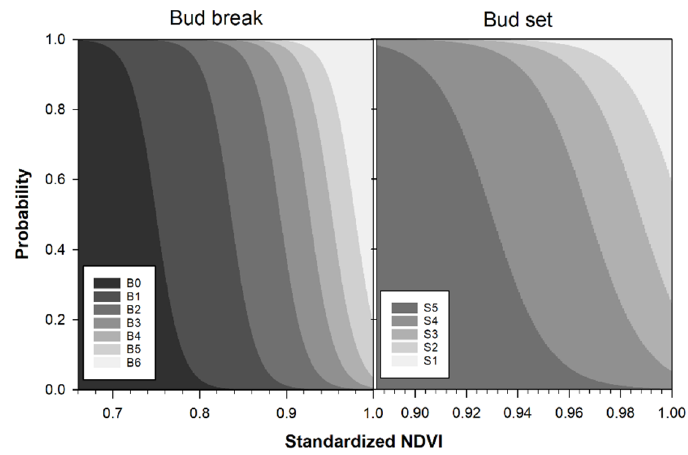
Figure 5. Probability of occurrence of phenological phases derived from field observations and standardized MODIS NDVI values of boreal black spruce stands in Quebec, Canada.